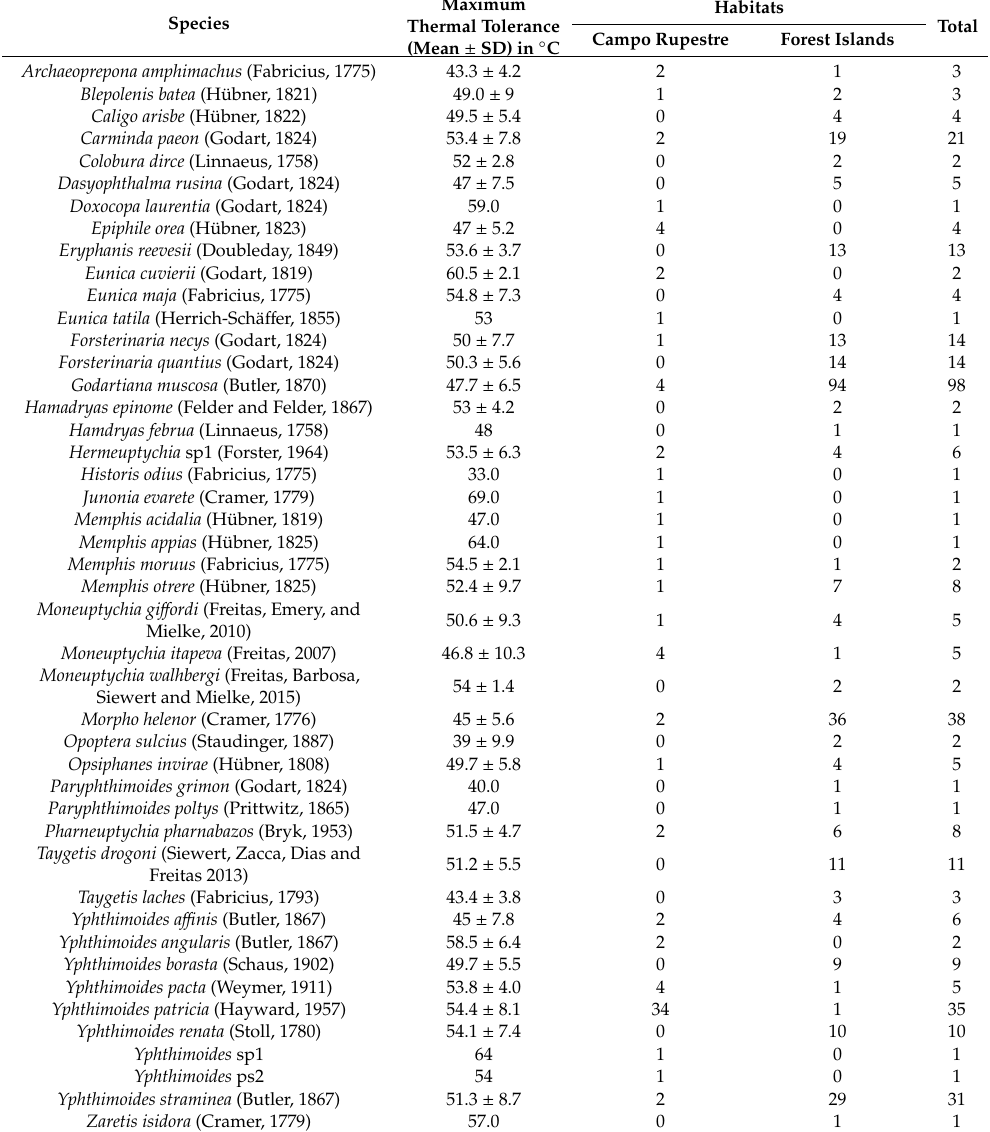
Table 1. List of butterfly species tested for thermal tolerance in Serra do Ouro Branco State Park, with the mean thermal tolerance and the habitat that